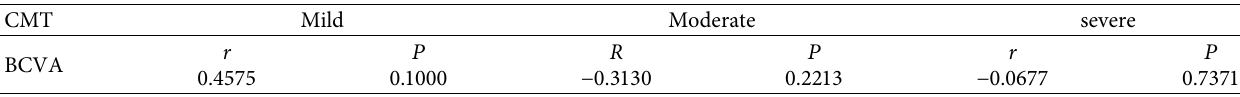
Table 3: Correlation analysis of BCVA and the severity of ME.